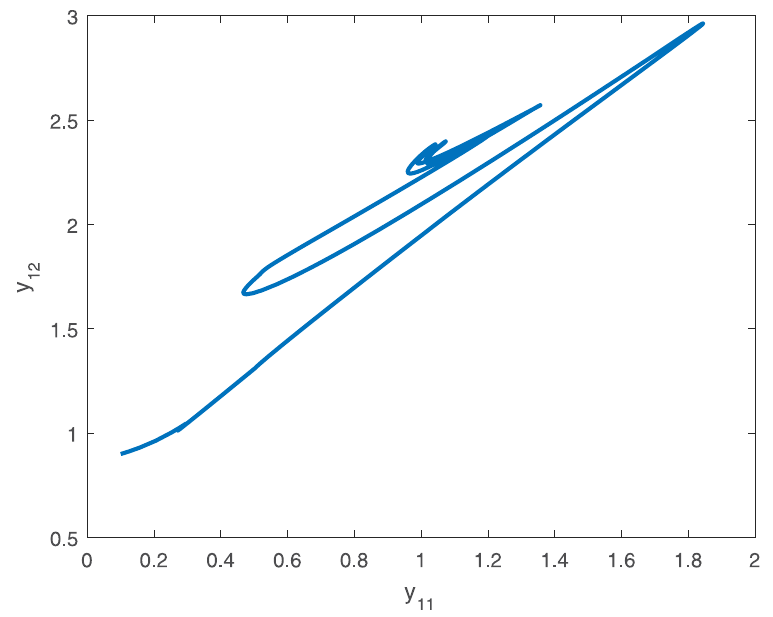
Fig 4. The phase diagram of the first neuron ( y 11 − y 12 ) of the response system (19) with initial conditions y 1 ( t 0 ) = [0.1 + sin ( t ), cos ( t ) − 0.1] T , y 2 ( t 0 ) = [ sin ( t ) − 0.1, 0.1 + cos ( t )] T , y 3 ( t 0 ) = [0.5 + sin ( t ), cos ( t ) − 0.5] T when no controller (8).